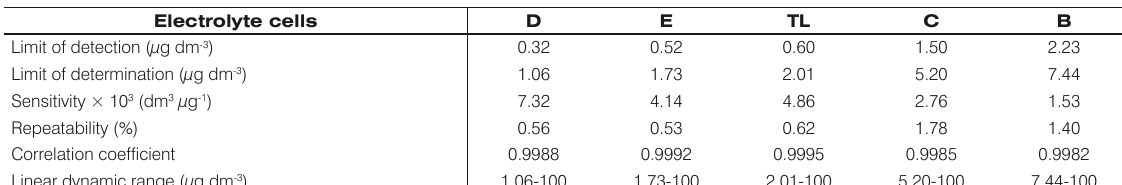
Table 2. Basic characteristics of Se determination.